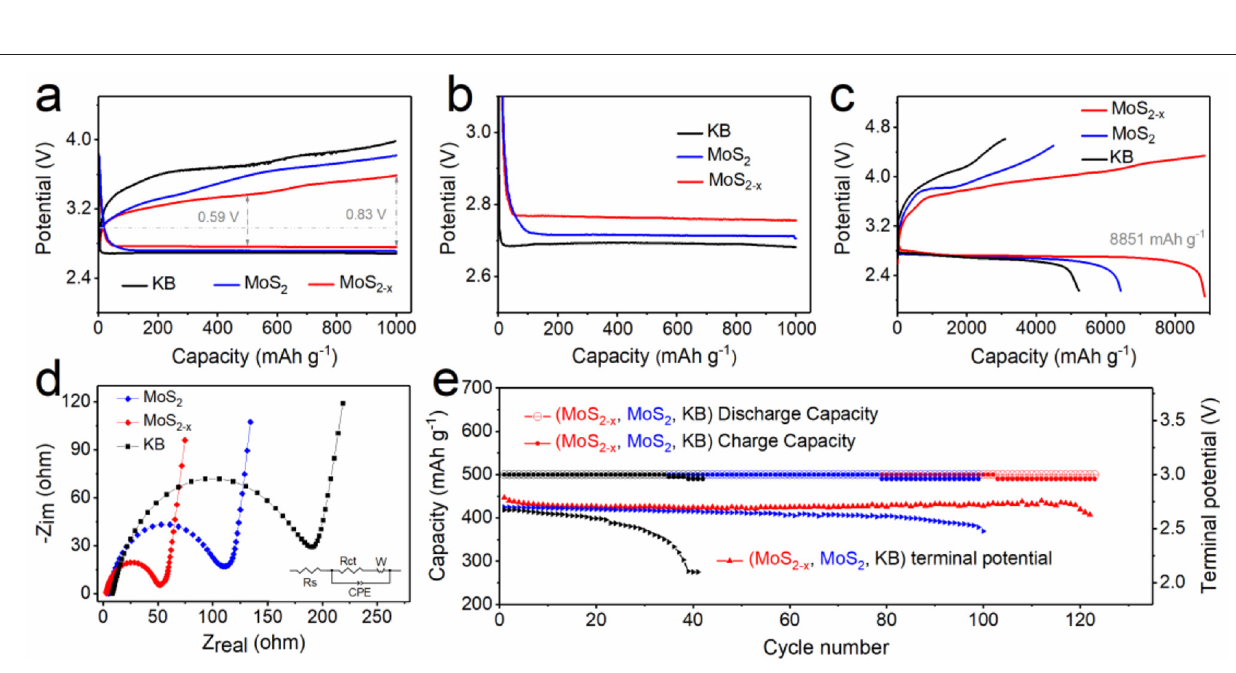
caused most likely by the removal of sulfur atoms. The resultant reduction of Mo, moving it to a lower oxidation state with a larger atomic radius, led to the increase in the lattice